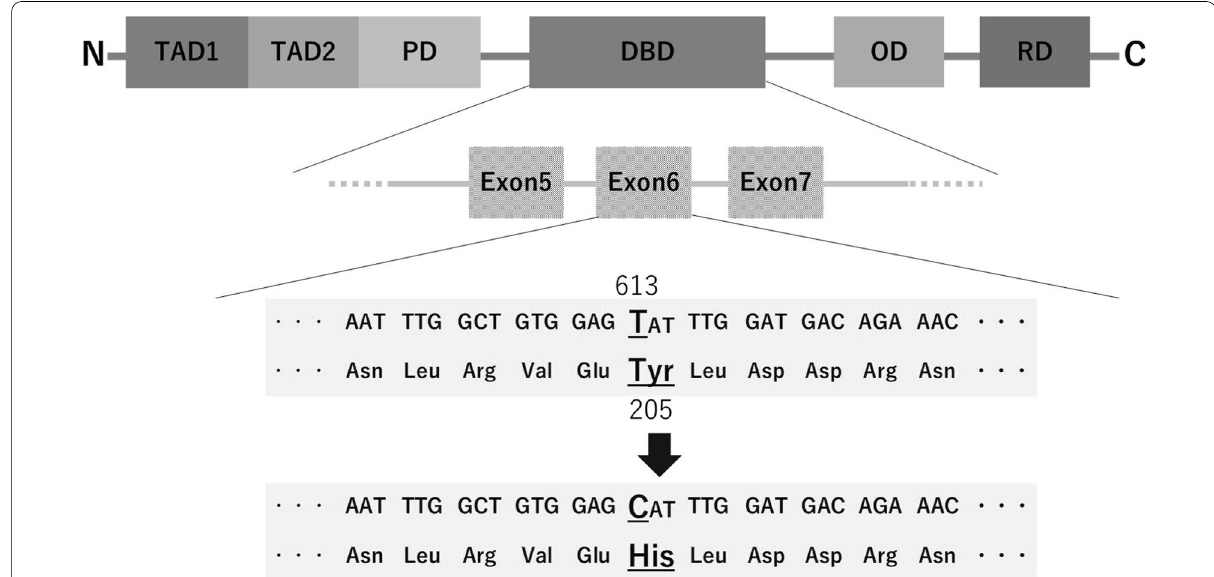
Fig. 2 Schematic diagram of the TP53 gene. 613T>C (p.Tyr205His) is highlighted by underbar. TAD transactivation domain, PD proline-rich domain, DBD DNA binding domain, OD oligomerization domain, RD lysine-rich regulatory